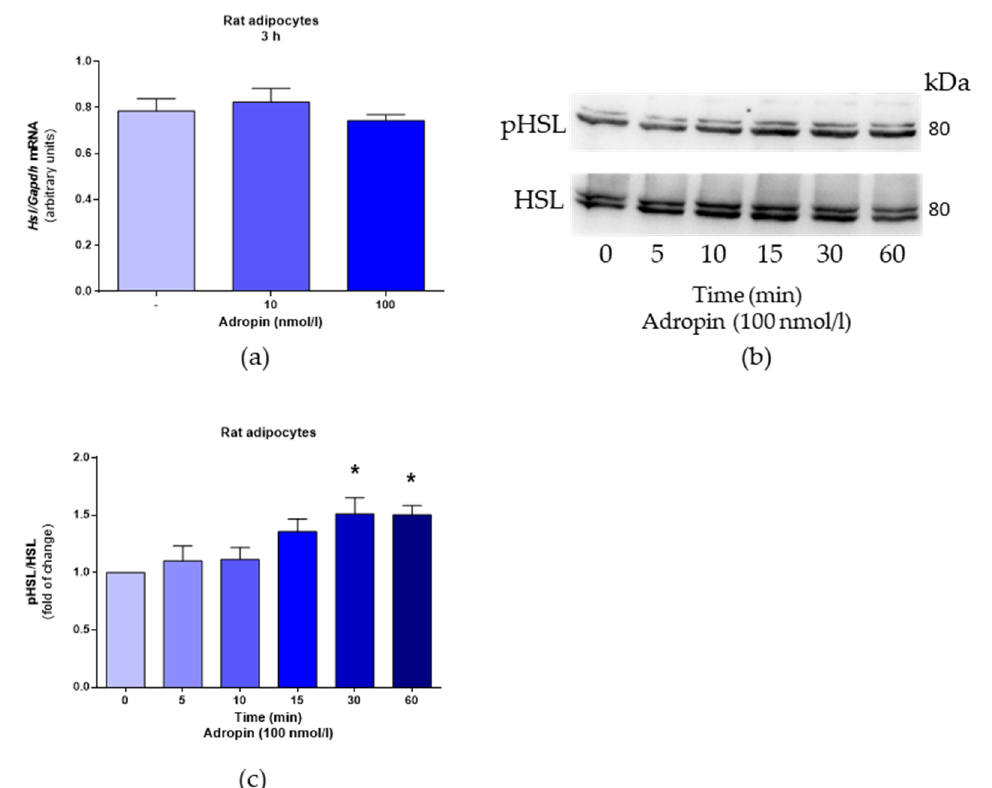
Figure 2. The effects of adropin (10 or 100 nmol/L) or vehicle (sterile distilled water) (-) on lipolysis in rat primary adipocytes and 3T3-L1 adipocytes. The effects of adropin (10 or 100 nmol/L) on glyc- erol release in rat adipocytes assessed after 3 ( a ) or 24 h ( b ) of incubation. FFA release determined in rat adipocytes exposed to adropin for 3 ( c ) and 24 h ( d ). The effects of adropin on glycerol release in 3T3-L1 cells treated with adropin for 3 ( e ) or 24 h ( f ). Secretion of FFA from 3T3-L1 incubated in the presence of adropin for 3 ( g ) or 24 h ( h ). Results are the mean ± SEM (n = 5–6). p < 0.05 (*).